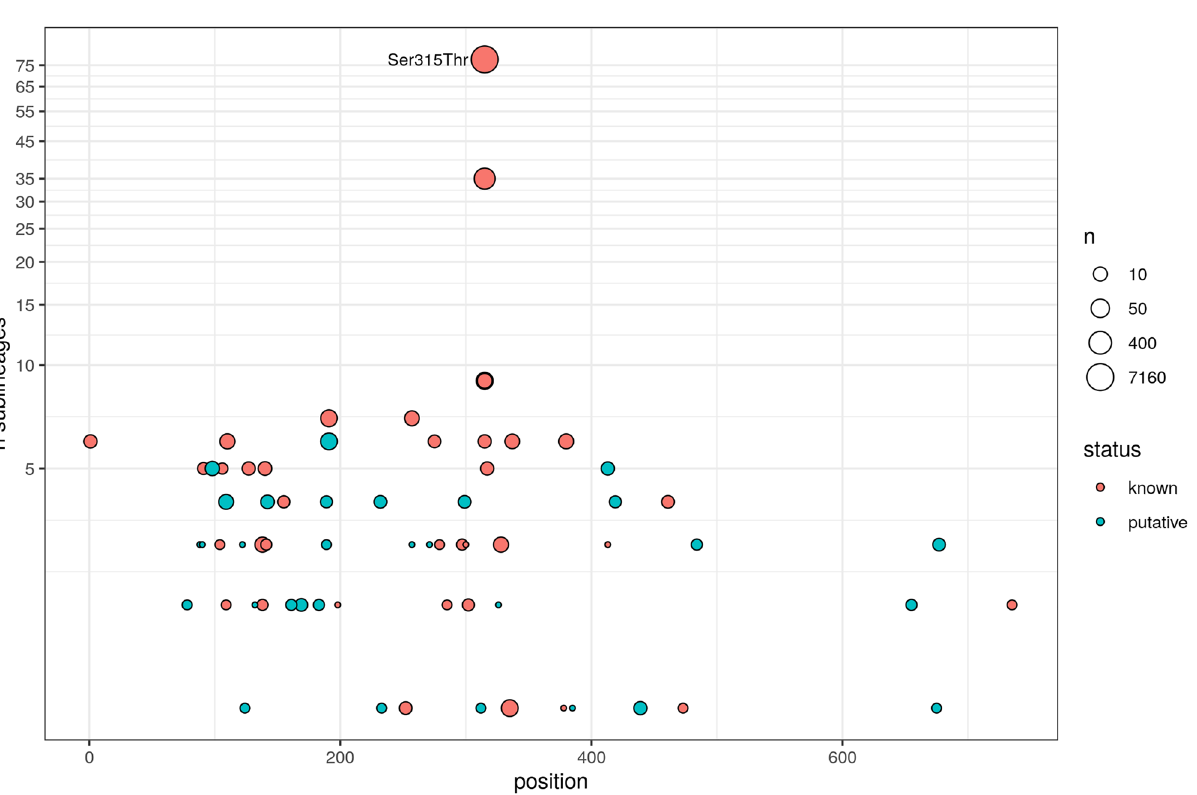
Figure 2. Homoplasy among 40 known katG and 31 putative resistance katG mutations. The common katG Ser315Thr mutation is highlighted. Mutations occurring in < 3 isolates and non-protein coding regions are